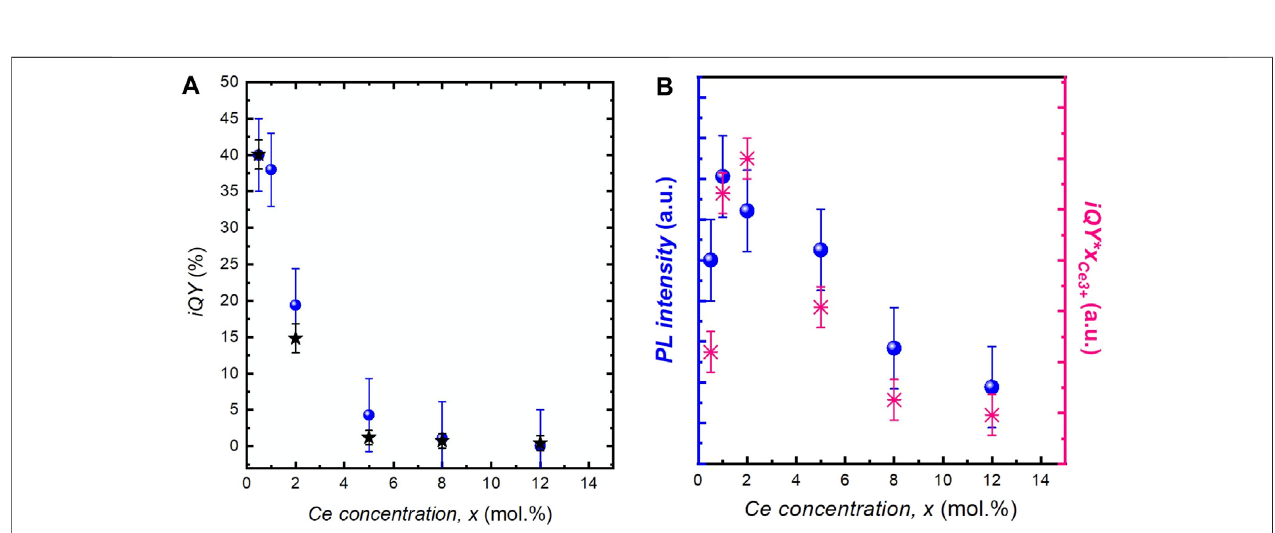
FIGURE 6 | (A) Evolution of iQY as a function of the cerium concentration, x, in YAG:Ce nanocrystals (blue dots). The black stars correspond to the integrated PL decay at 540 nm. (B) Brightness of YAG:Ce nanocrystals obtained by the direct measurement of the PL intensity (in blue) and by multiplying iQY by x Ce3+ (in pink).